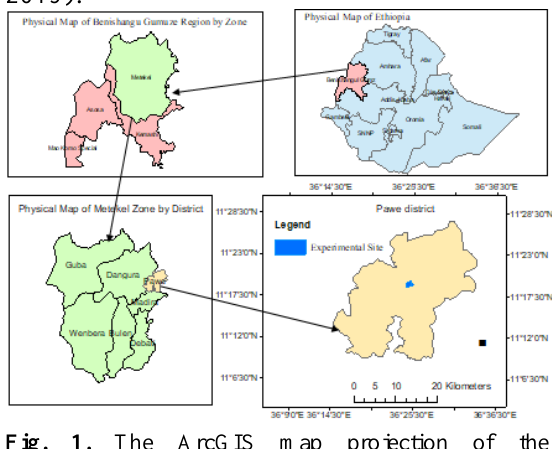
Fig. 1. The ArcGIS map projection of the experimental